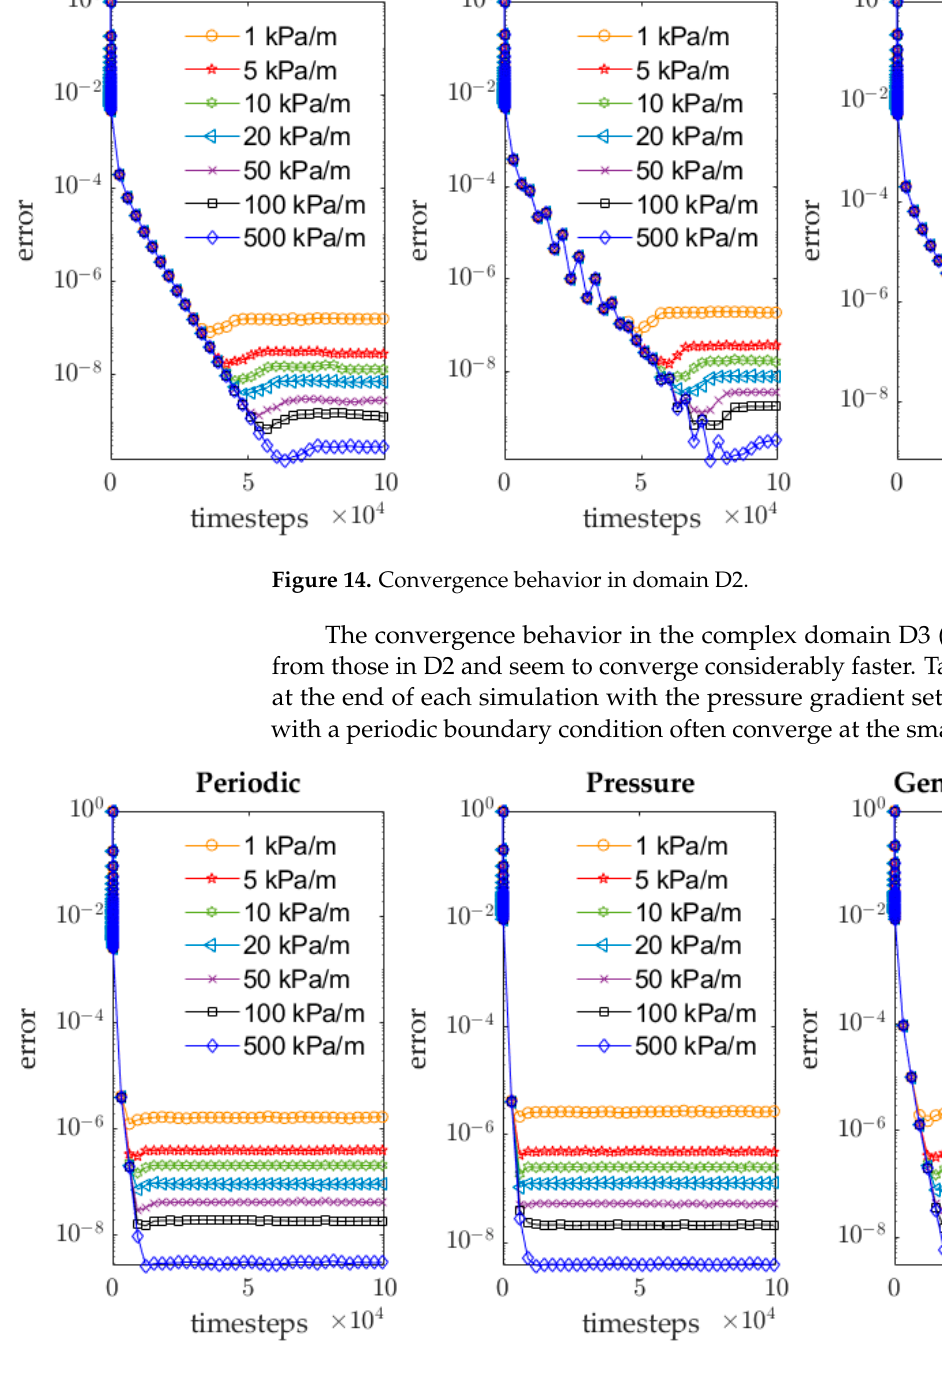
Figure 15. Convergence behavior in domain D3. Table 1. Summary of final error values.